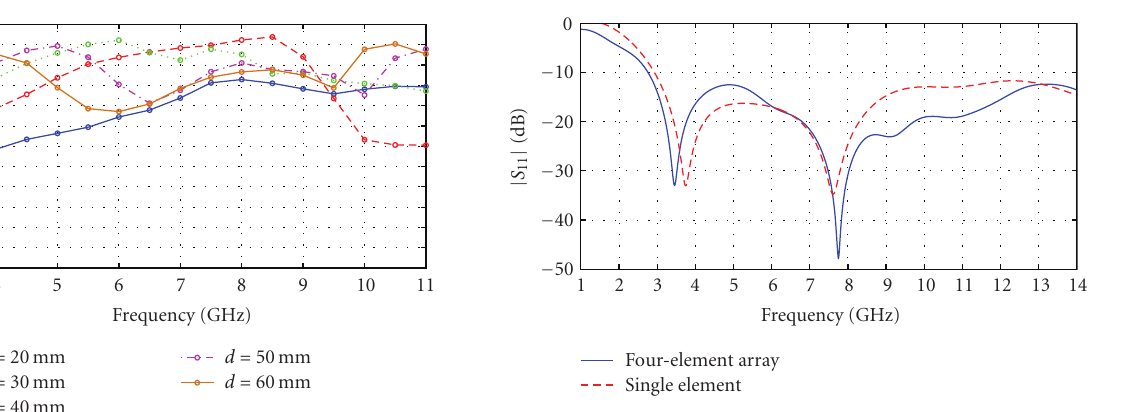
Figure 16: Simulated realized gain results of four-element UWB array.